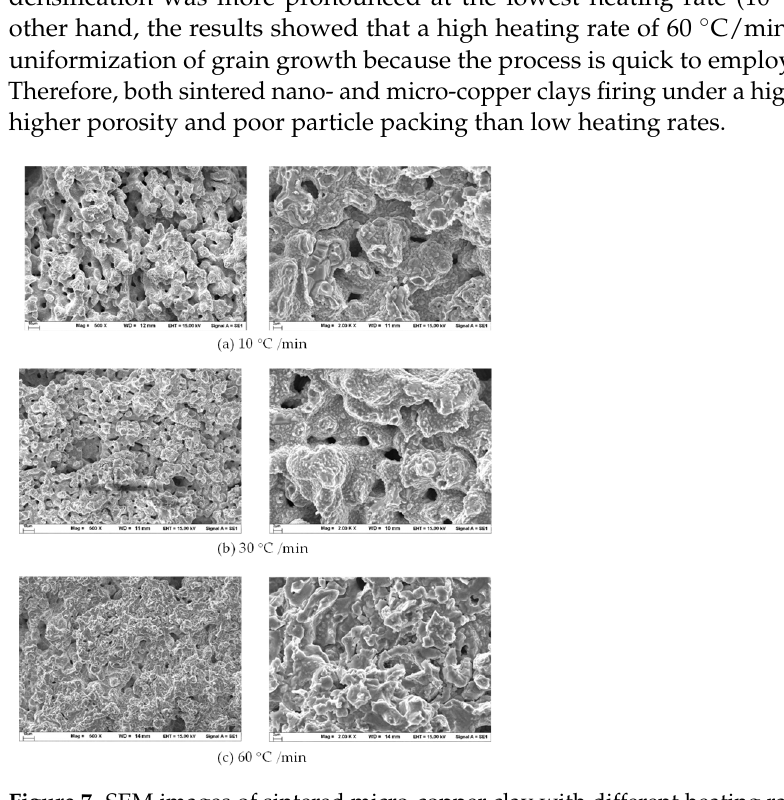
Figure 7. SEM images of sintered micro-copper clay with different heating rates at ( a ) 10 °C/min, ( b ) 30 °C/min, and ( c ) 60 °C/min. ( b ) 30 ◦ C/min, and ( c ) 60 ◦